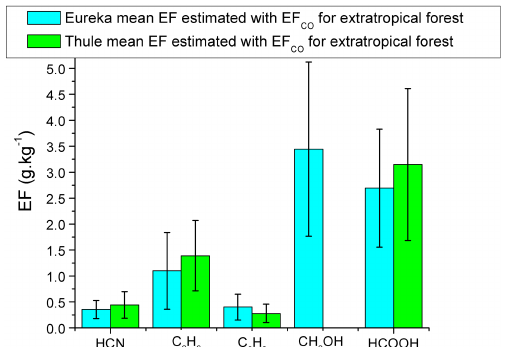
Figure 9. Emission factors calculated from the FTIR measurements performed at Eureka (cyan) and Thule (green), using EF CO of An- dreae and Merlet (2001) for extratropical forest. Error bars corre- spond to the uncertainty in the CO emission factor and the uncer- tainty in the calculated regression slope, as well as the total uncer- tainties in the retrievals, all combined in quadrature.